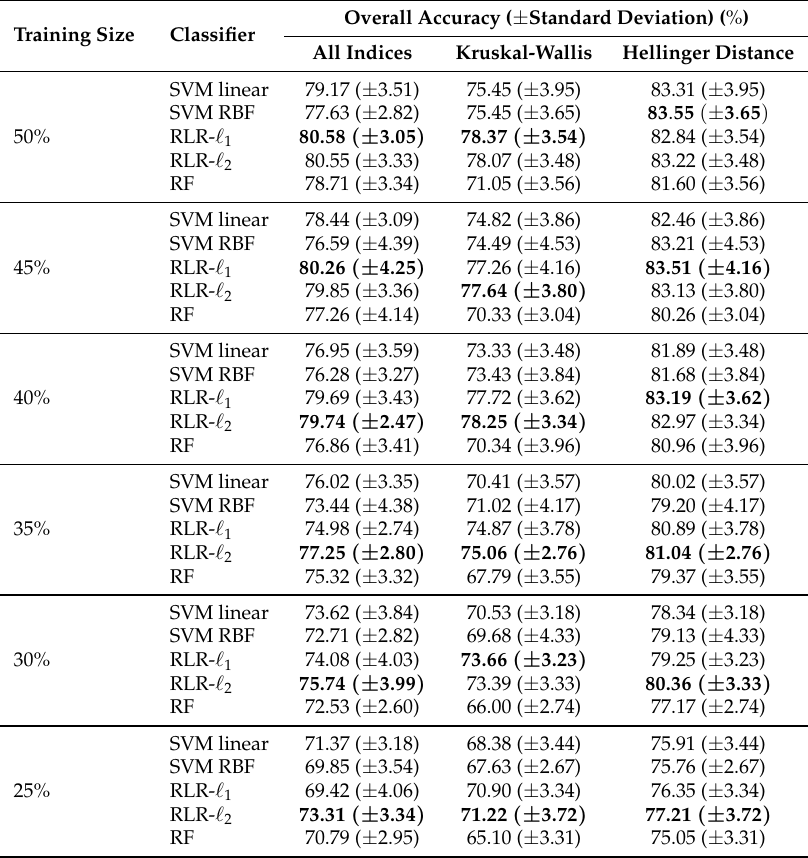
Table 14. Vegetation types identification (overall accuracy ( ± standard deviation) in %) with